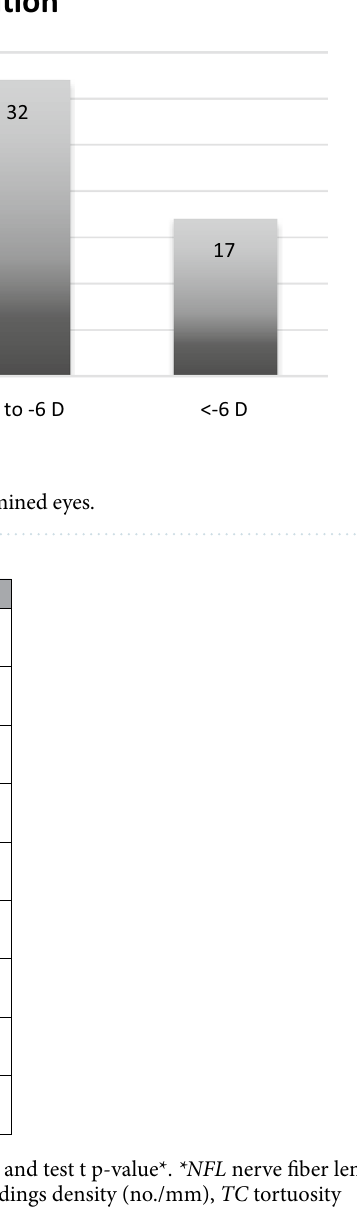
SBNP parameters. Table 4 reports the correlations between all variables considered in this study, and Table 5 shows the results of the four multiple regression models for the dependent variables NFL, NFD, NBD and TC respectively. Nerve fibers length. Mean NFL was 8515.546 ± 206.899 µm/mm 2 and significantly inversely correlated with